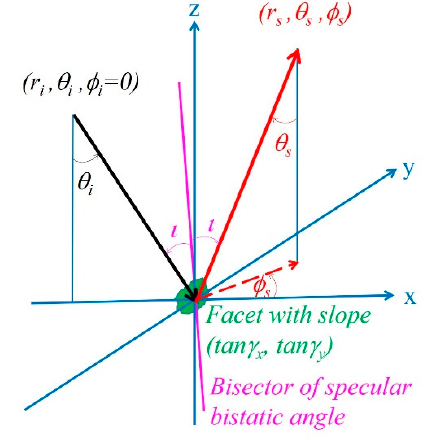
Figure 1. The scattering geometry from a surface facet. The average number of specular points per unit area for a rough surface and the average radii of curvatures are then derived in terms of the surface statistics. Sections 2 and 3 of Barrick [5] and Appendix B of Barrick [6] give the detailed mathematical derivation of n A and <| r 1 r 2 |>. The final results are copied here: